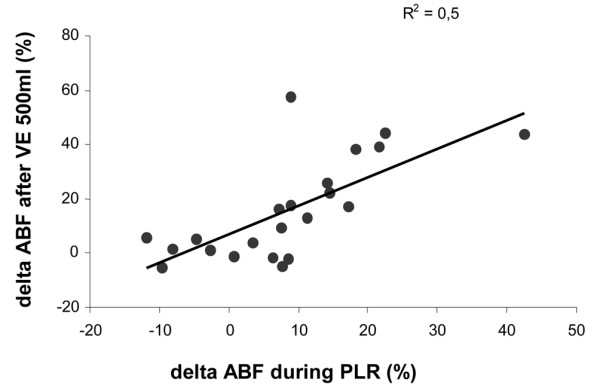
Relationship between changes in ABF induced by PLR and VE. Abbreviations: ABF = aortic blood flow; PLR = passive leg raising; VE = volume expansion. Results are expressed as percentage variation from Base 1 value for PLR and from Base 2 value for VE.